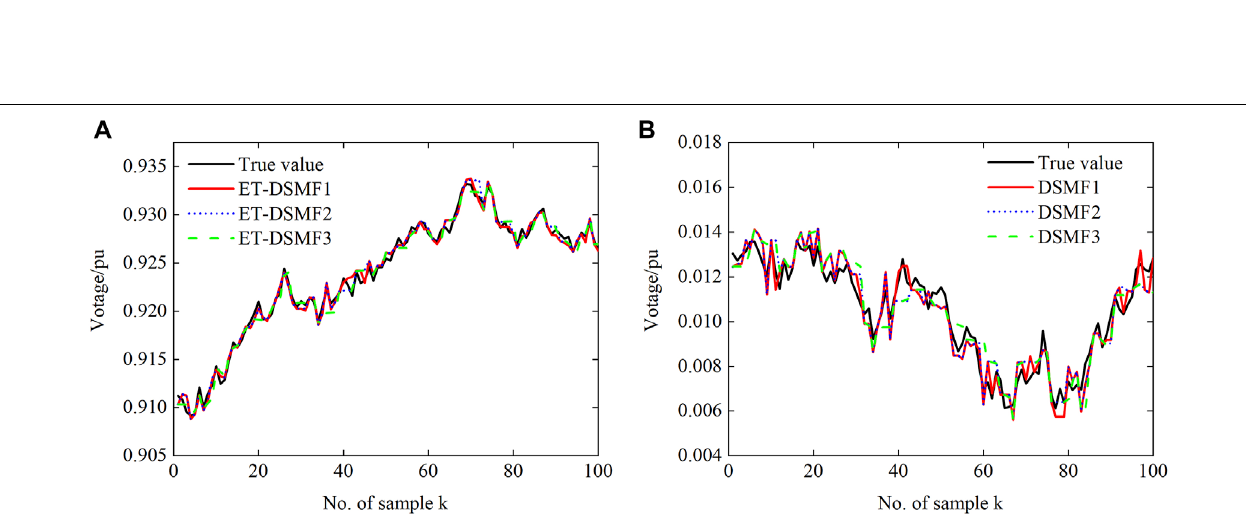
FIGURE 10 | The true and estimated values of c-phase at bus 4: (A) the real part of the voltage and (B) the imaginary part of the voltage.